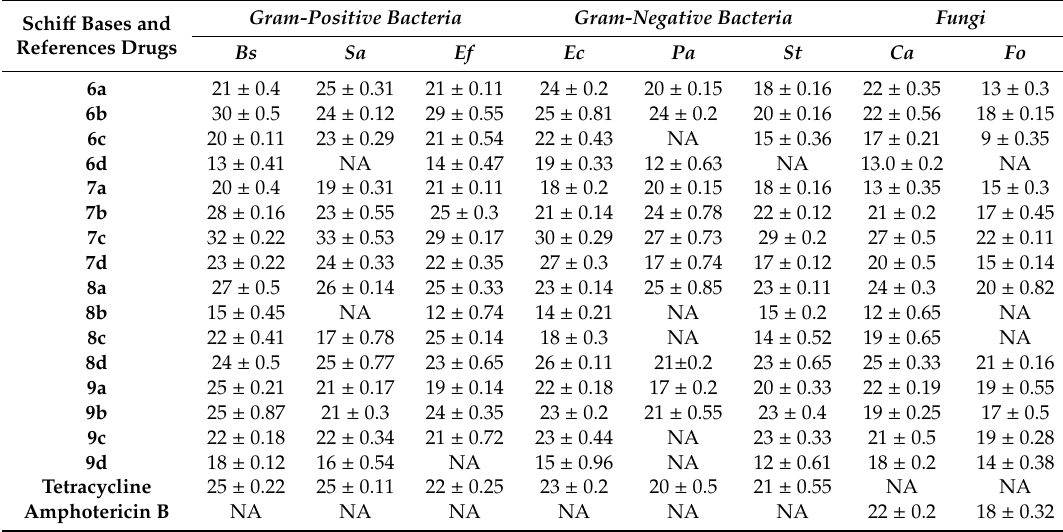
Table 1. Inhibition zone (IZ) in mm ± standard deviation of Schi ff bases ( 6a – d , 7a – d , 8a – d, and 9a – d ) Table 1 : Inhibition zone (IZ) in mm ± standard deviation of Schiff bases ( 6a – d , 7a – d , 8a – d, and 9a – d ) and and reference drugs against pathogenic reference drugs against pathogenic microbes.